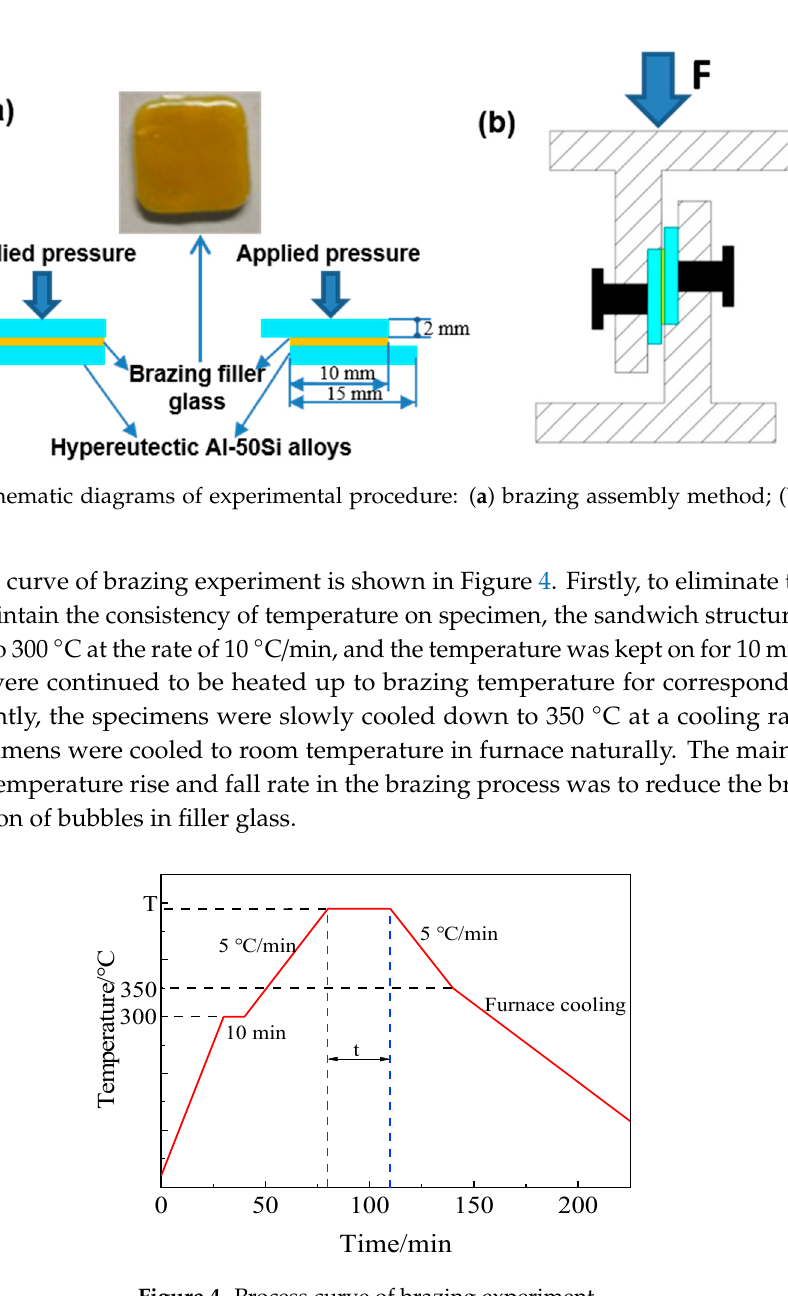
Figure 4. Process curve of brazing experiment.